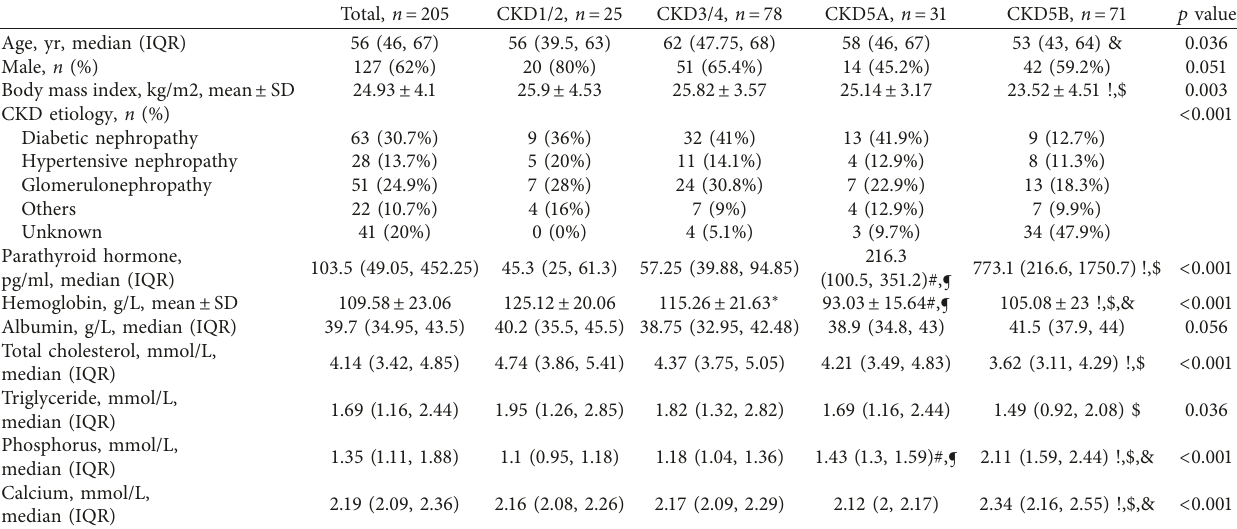
Table 1: Basic indicators of different CKD stage groups.